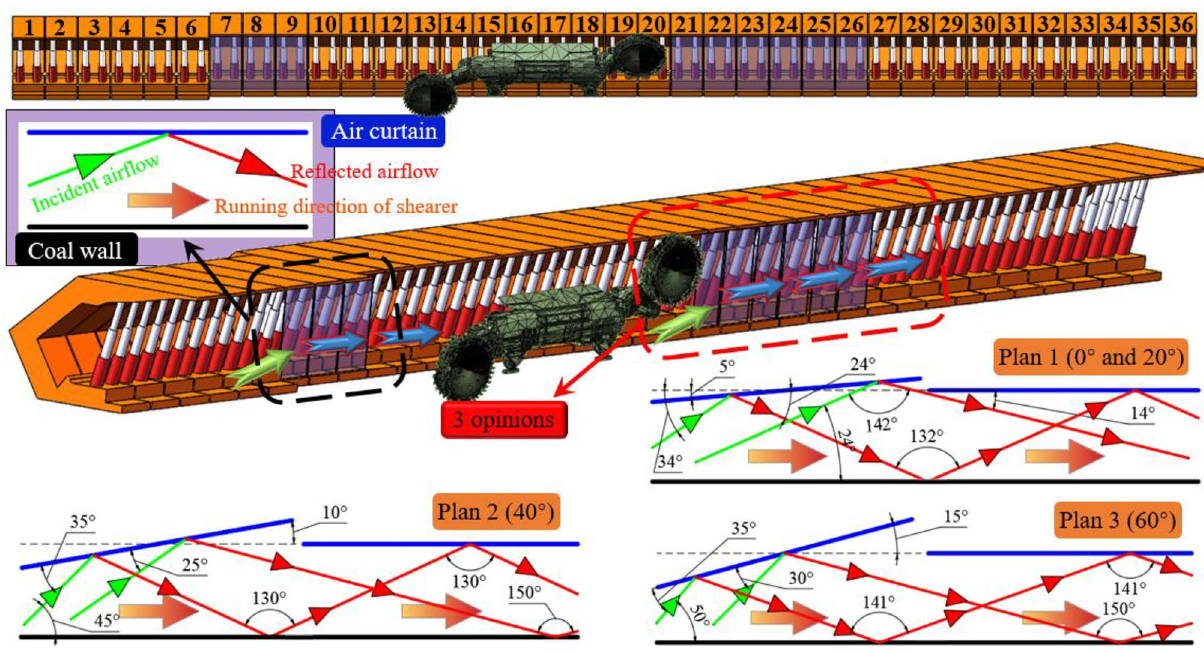
Figure 10. Diagram of wind curtain